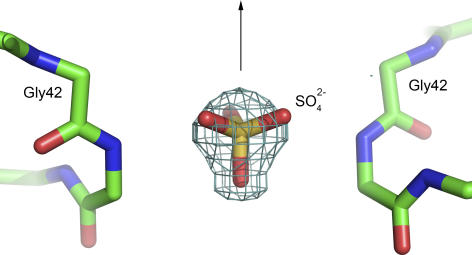
A Sulfate Ion Found in the Pore of the CsoS1A HexamerThe (Fobs-Fcalc) difference electron density map shown was calculated using diffraction data from a crystal soaked in sodium sulfate. The map is contoured at 3σ. The view is with the pore (arrow) running vertically in the plane of the paper. The pore is lined by the polypeptide backbone from all six proteins in a hexamer (two copies are shown). The identity of the sulfate ion was supported by an anomalous difference map (Figure S3).